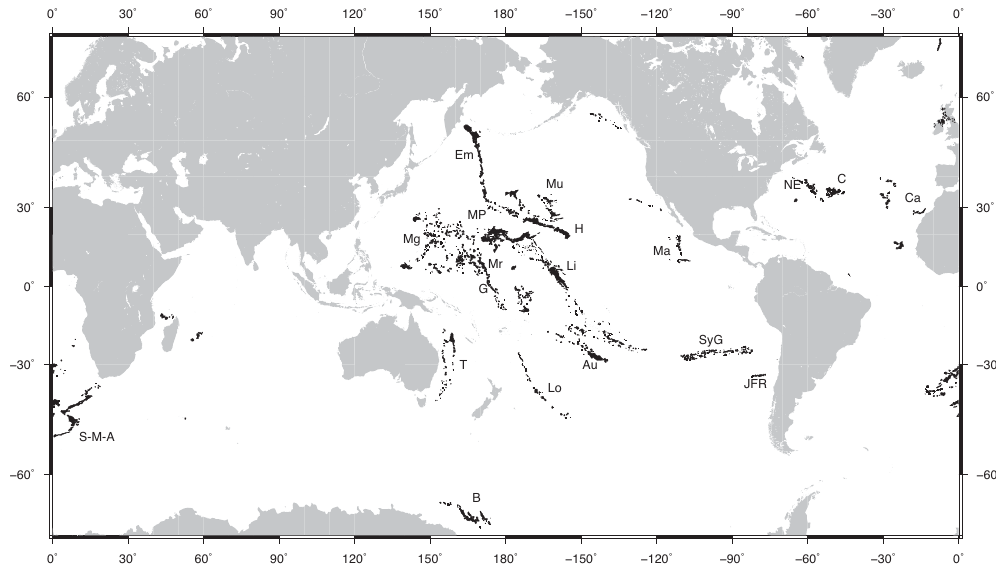
Figure 5. Location map of seamounts (shown in black). Revised from LIP list of Coffin and Eldholm (1994). Seamounts labeled